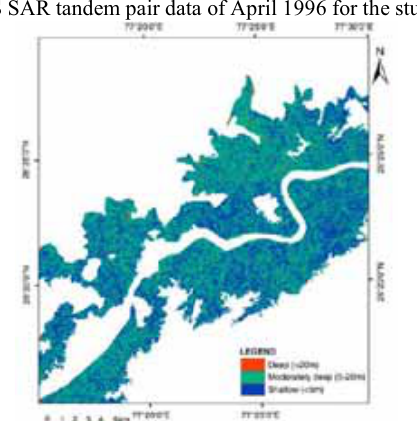
Fig.4: Interferogram (a) and from ERS SAR tandem pair data